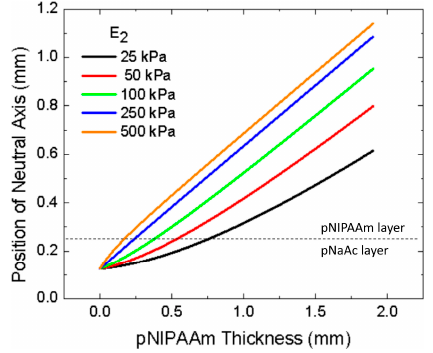
Figure A1. Position of the neutral axis as a function of the pNIPAAm thickness. The dashed line marks the interface between the two gel layers.